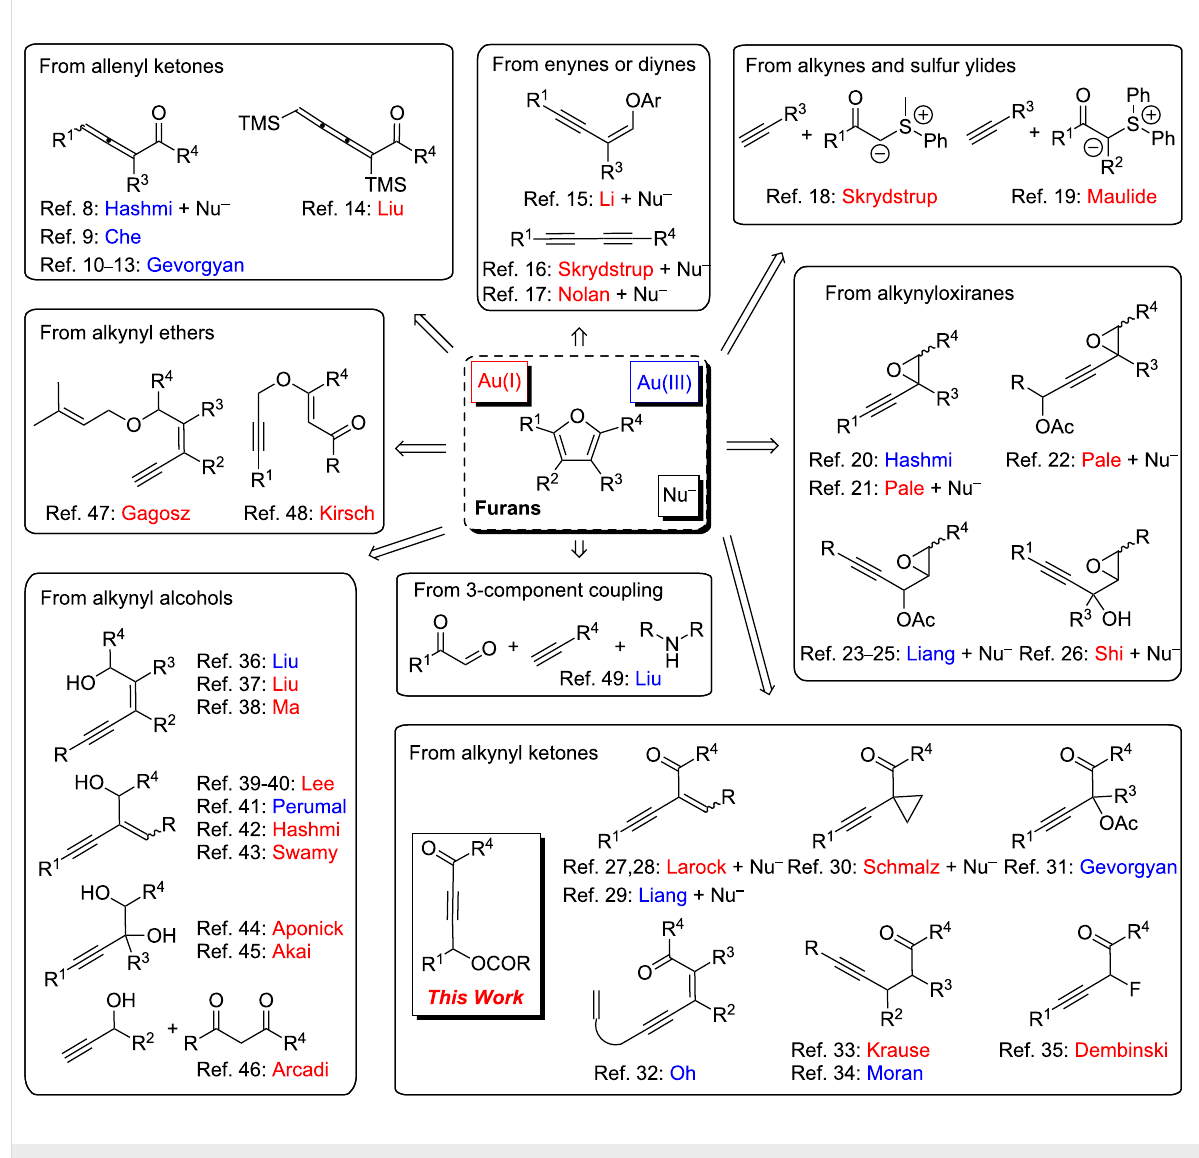
Scheme 1: Gold(I) or gold(III)-catalyzed furan syntheses with or without nucleophiles.